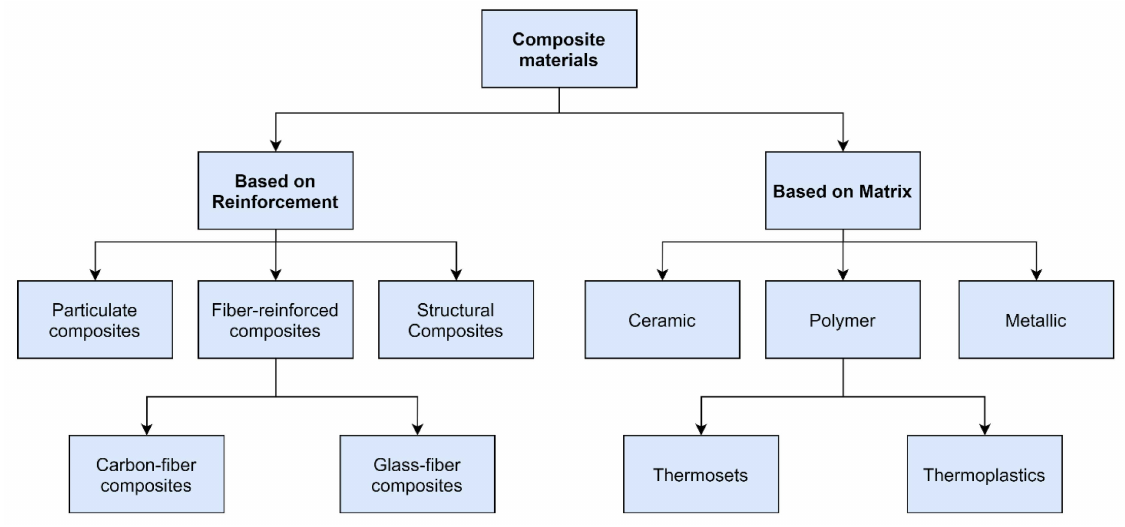
Figure 3. Composites classification based on the reinforcement and the matrix type.